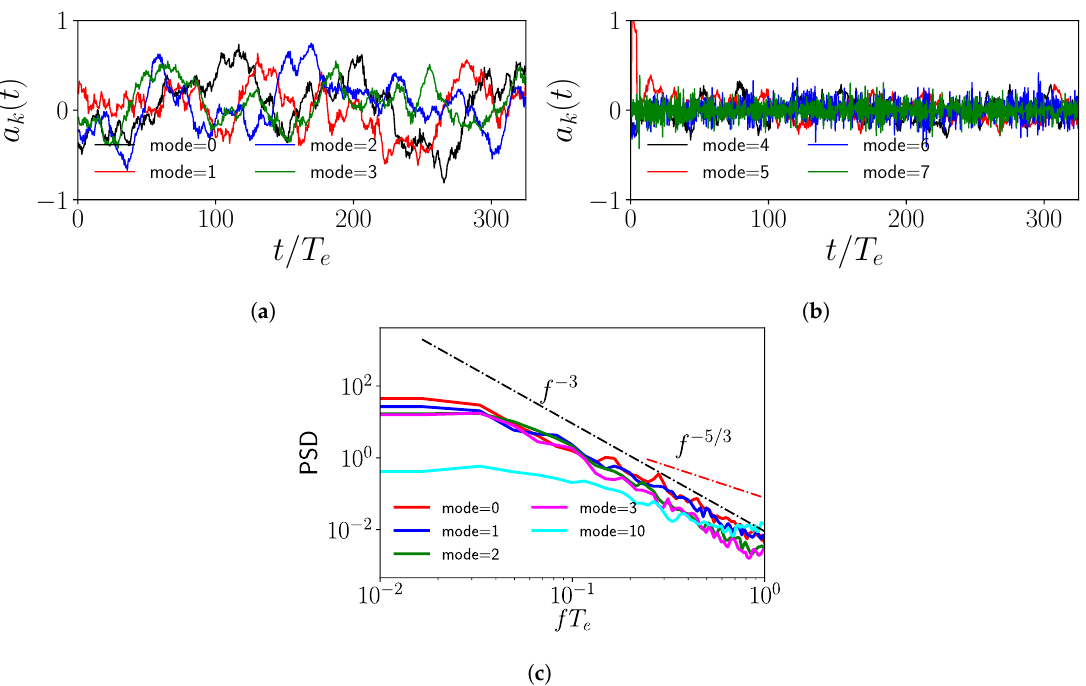
Figure 8. ( a , b ) Projection coefficient of 3D POD modes, a m ( t ) vs time normalized by flow-through time, T e = 15 π d / U ∞ . ( c ) Power spectral density of the projection coefficients vs normalized frequency, f T e .